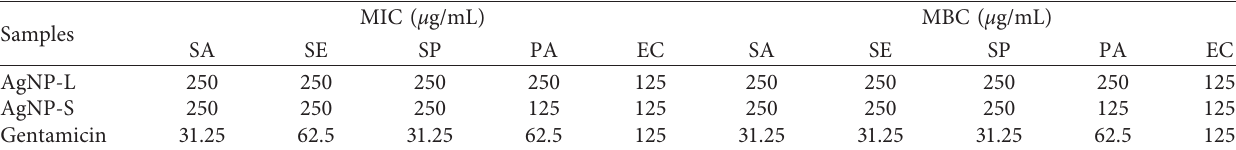
Table 3: MIC and MBC of tested samples against microorganisms.